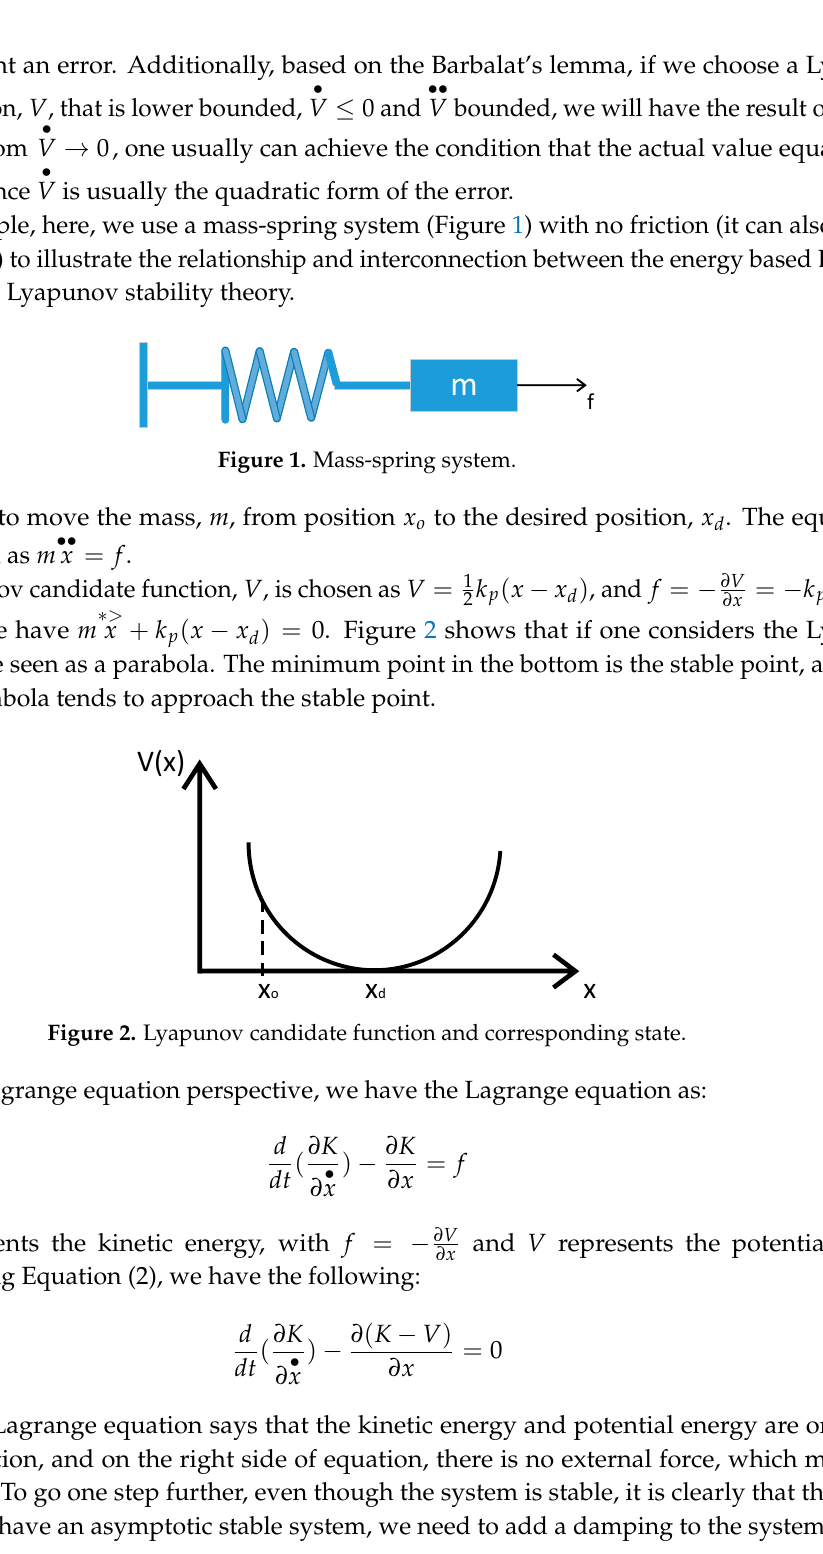
Figure 1. Mass-spring system.